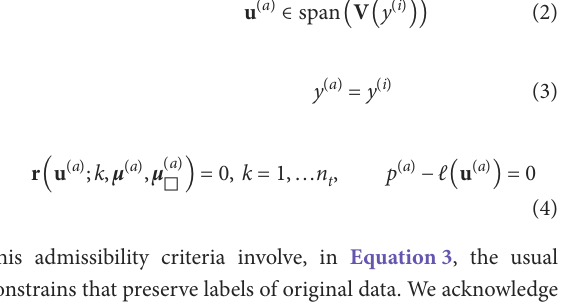
FIGURE 1 Schematic view of augmented data (blue crosses) around digital twins (red points) in a multimodal ambient space ( μ , μ □ , u ). Oversampling assumes a piecewise linear latent space (green slopes). Each linear subset of the latent space has a dedicated label y . The extent of green segments illustrates the validity domain of